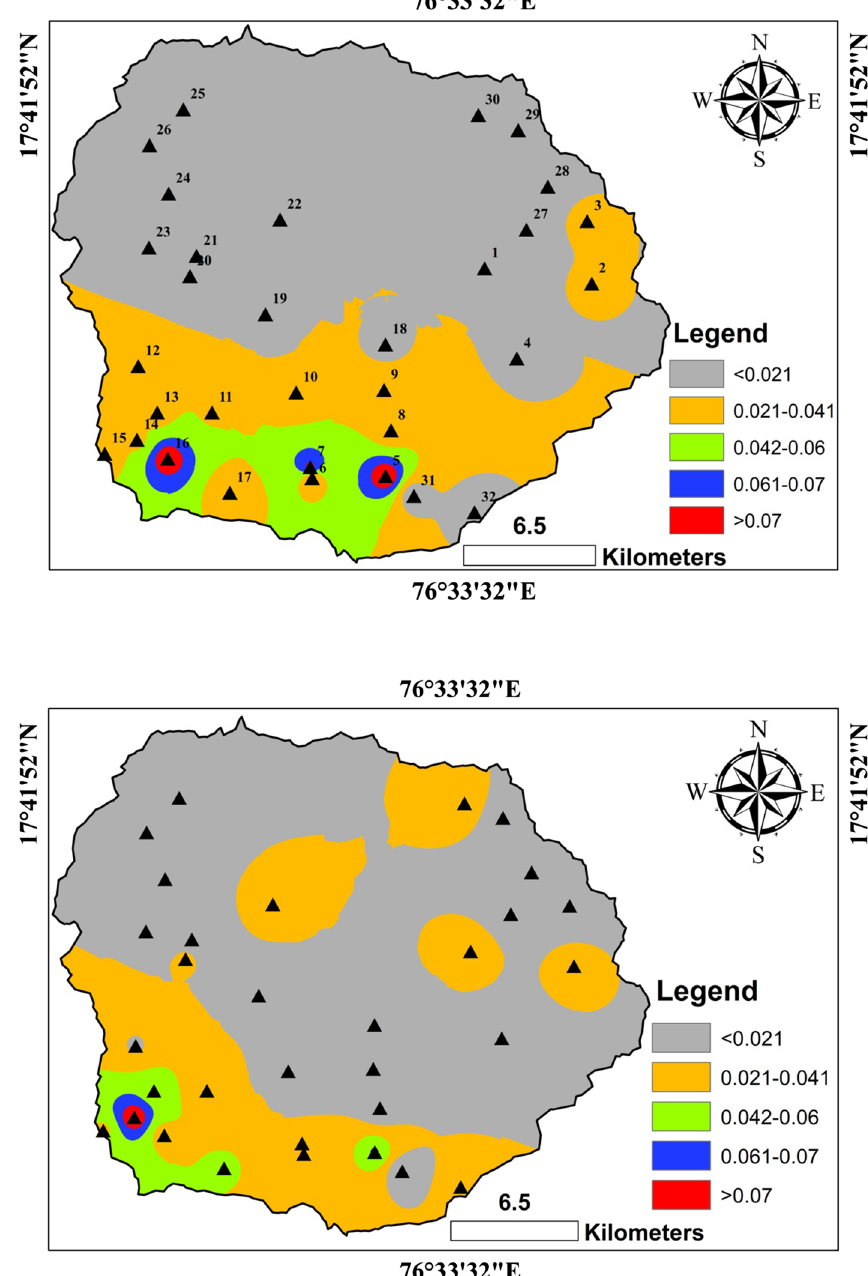
Fig. 16 Geospatial distribution of iron (pre-monsoon)